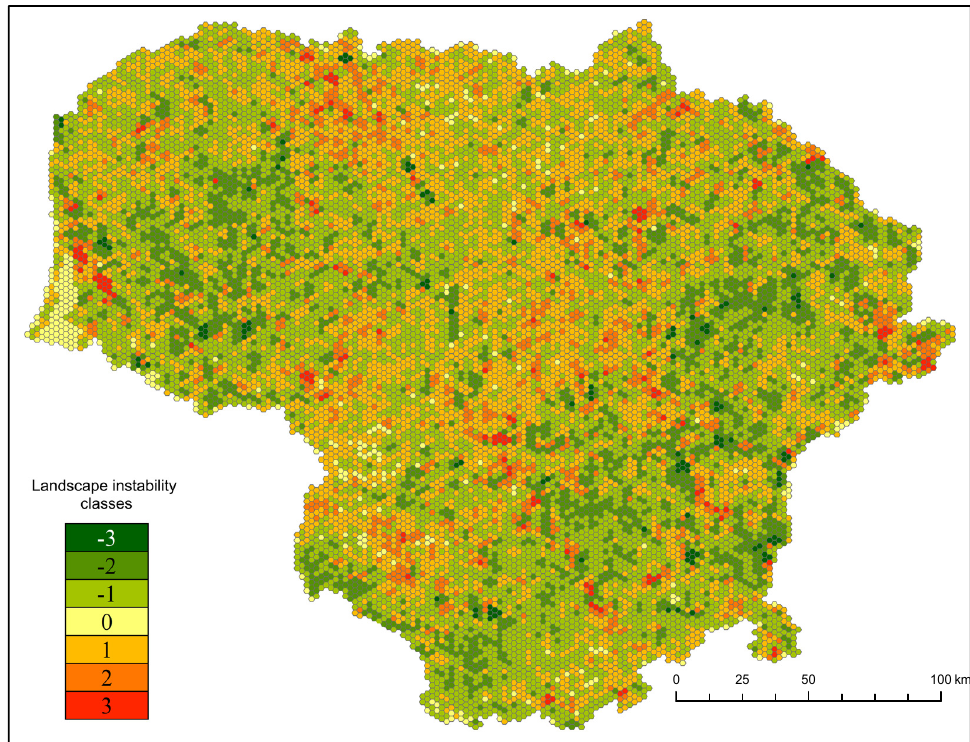
Figure 8. Landscape instability in Lithuania, 1995–2018. Landscape instability classes represented in Table 3.